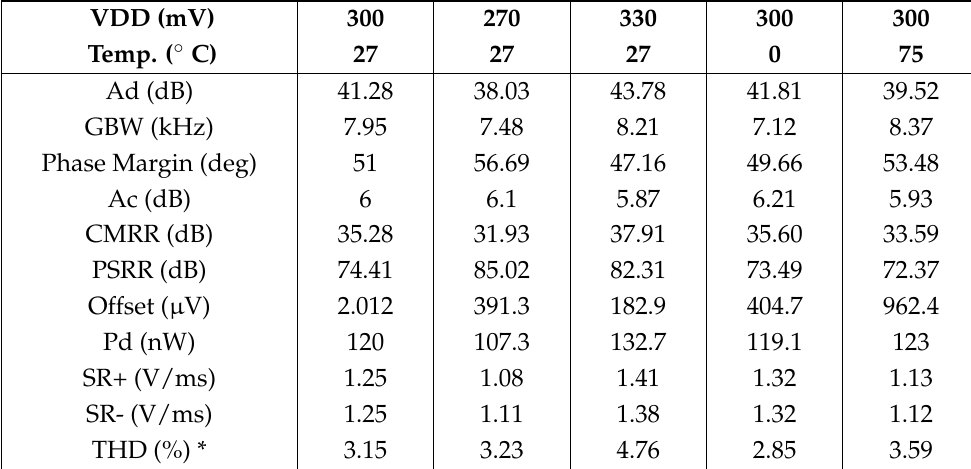
Table 2. OTA performance vs. supply voltage and temperature.